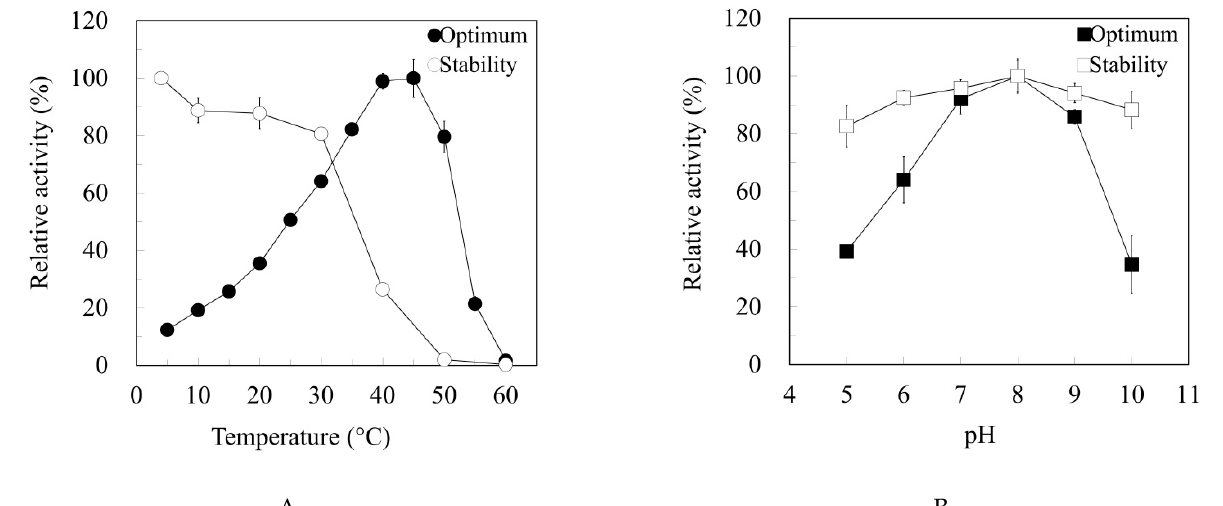
Figure 3. Effect of pH and temperature on activity and stability of Est6. ( A ) The enzyme activity was measured at an absorbance of 348 nm in various pH buffers at 30 °C. The value obtained at pH 8.0 was taken as 100%. Optimal pH tests were displayed as filled squares. The pH stability of the enzyme preserved in various pH buffers for 24 h at 4 °C was demonstrated as open square. The enzyme activity was measured at an absorbance of 348 nm in a pH 8.0 buffer at 30 °C. Error bars indicate standard deviations. ( B ) The enzyme activity was measured at various temperatures at pH 8.0 under standard assay conditions. The relative activity obtained at 45 °C was taken as 100%. The test for the optimal temperature of Est6 was shown as a filled circle, while the thermostability of the enzyme at different temperatures was displayed as an open circle. The residual activity was determined after incubation of the enzyme at different temperatures for 1 h. The activity measurement was carried out using the standard enzyme assay. All samples and blanks were analyzed in triplicate. The relative activity of the enzyme preserved at 4 °C was taken as 100%. Error bars indicate standard deviations.